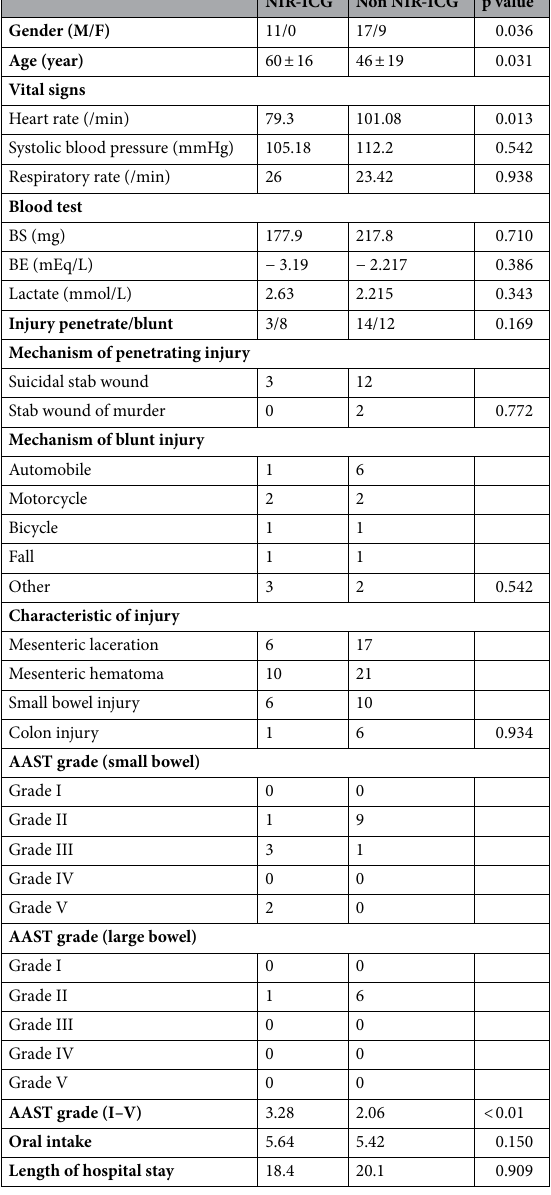
Table 1. Characteristics of the NIR-ICG and the non NIR-ICG